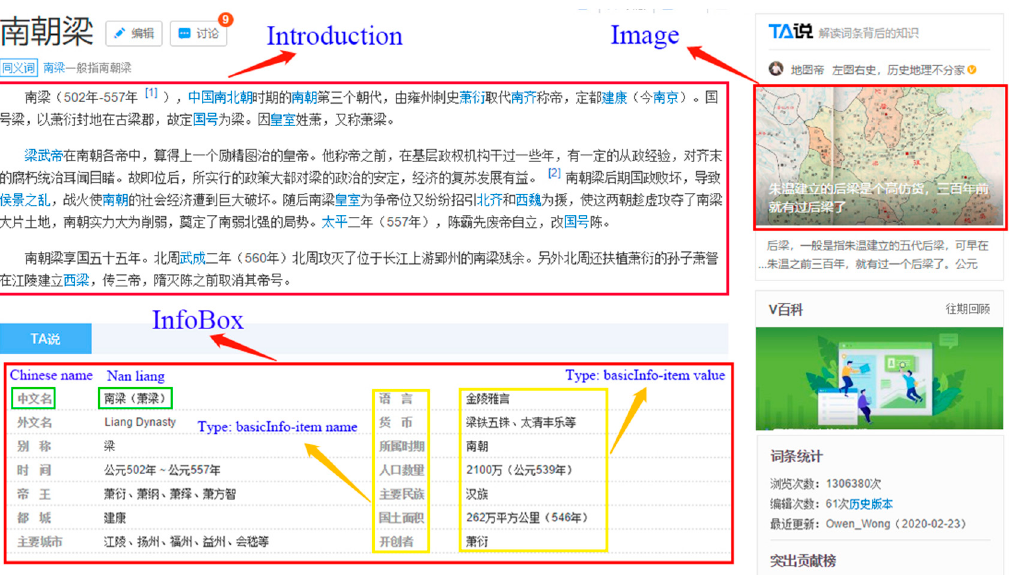
Figure 2. Baidu Encyclopedia data acquisition example (taking Nan Liang as an example), It is mainly divided into three parts. The first part is the Introduction part. This part is unstructured text data. After the extraction completed, the user named entity recognition and relationship extraction are performed. The second part is the Image part. This part mainly obtains the picture information. The obtained picture will be applied in the knowledge attribute query module of the knowledge graph system. The third part is the InfoBox part. This part is semi-structured data, which is mainly used to construct triples.